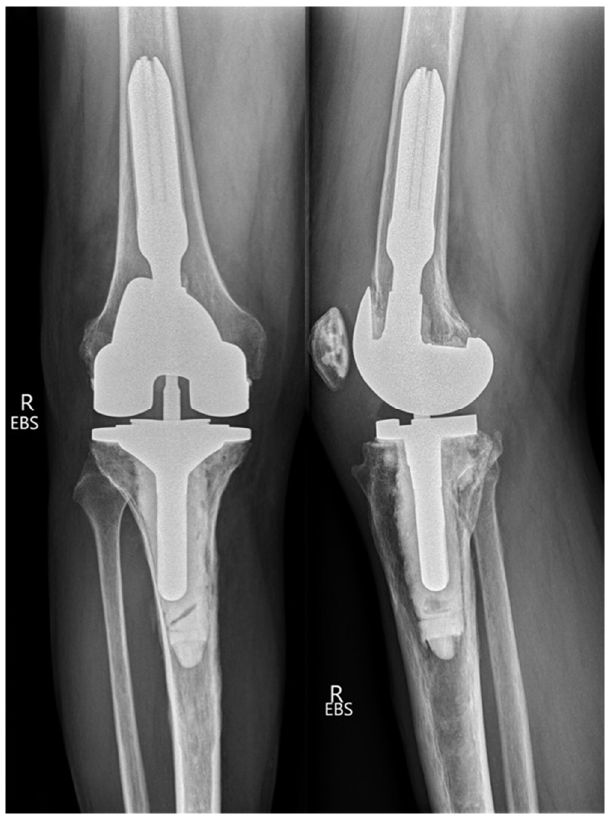
Figure 5. Anteroposterior and lateral non-weight bearing radiographs of the right knee after revision surgery with a semi-constrained TKA.